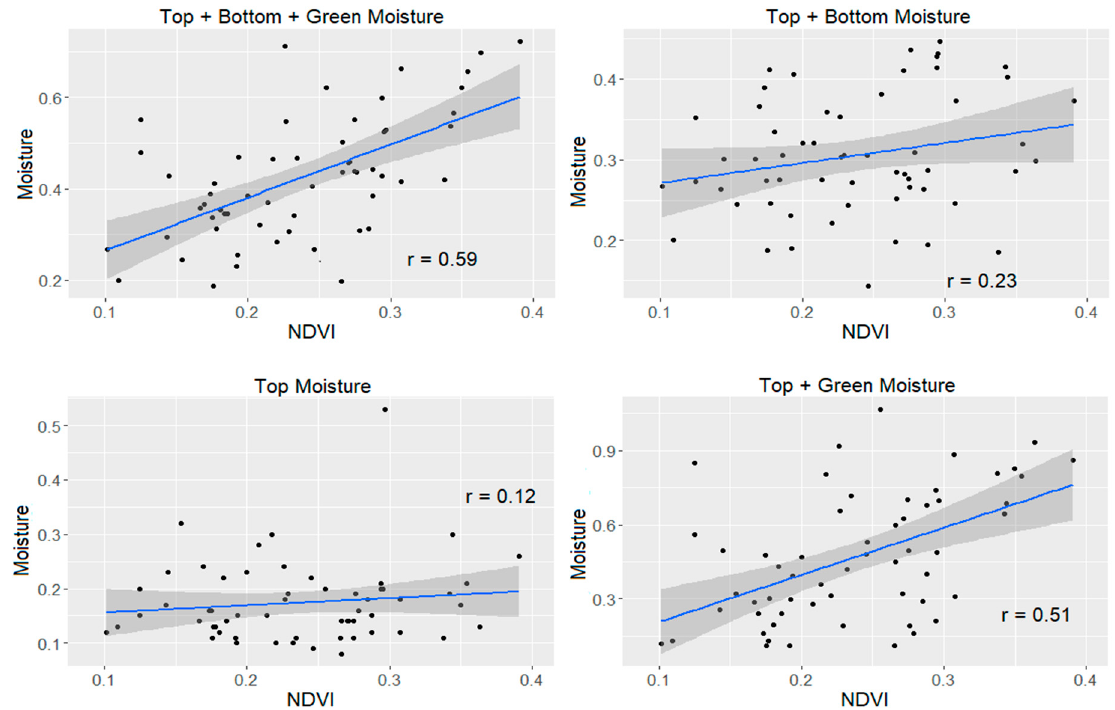
Figure 5. Comparison of the Relationship Between NDVI and Various Moisture Metrics for Tall Grass.